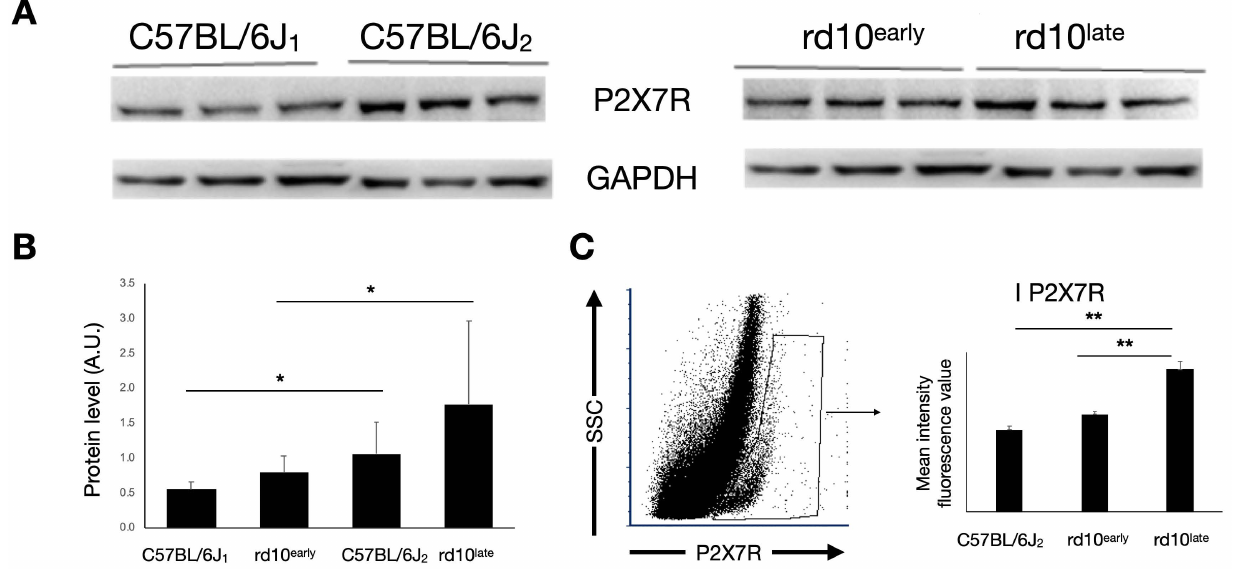
Figure 2. P2X7R expression in mouse retina. ( A ) Representative western blot and ( B ) protein quantification of P2X7R expression in C57BL/6J, rd10early, and rd10late mice. ( C ) Mean fluorescence values of P2X7R immunostaining in P2X7R-positive cells analyzed by flow cytometry in rd10early and rd10late mice compared with C57BL/6J mice. Student’s t -test * p < 0.05, ** p < 0.01. C57BL/6J1: postnatal day (P)20; C57BL/6J2: P40–P47; rd10early: P18 and rd10late: